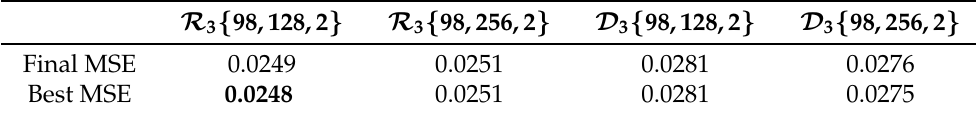
Table 2. Obtained MSE values from the corresponding